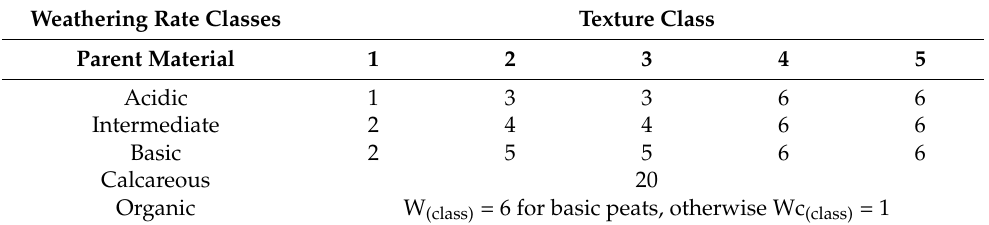
Table 20. Matrix for determining the weathering class (WR c ) from the substrate and texture class